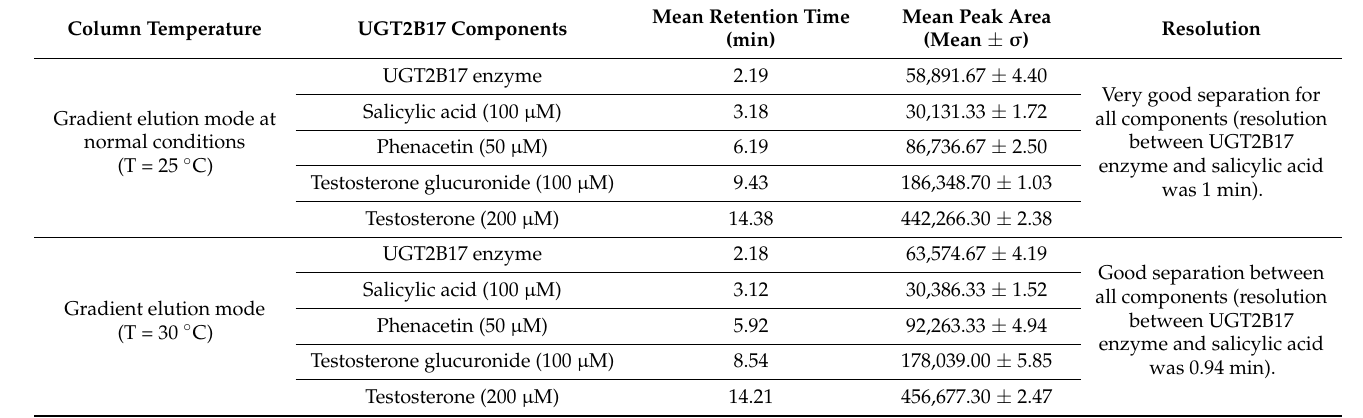
Table 4. Effect of column temperature on retention time and peak area of UGT2B17 components.